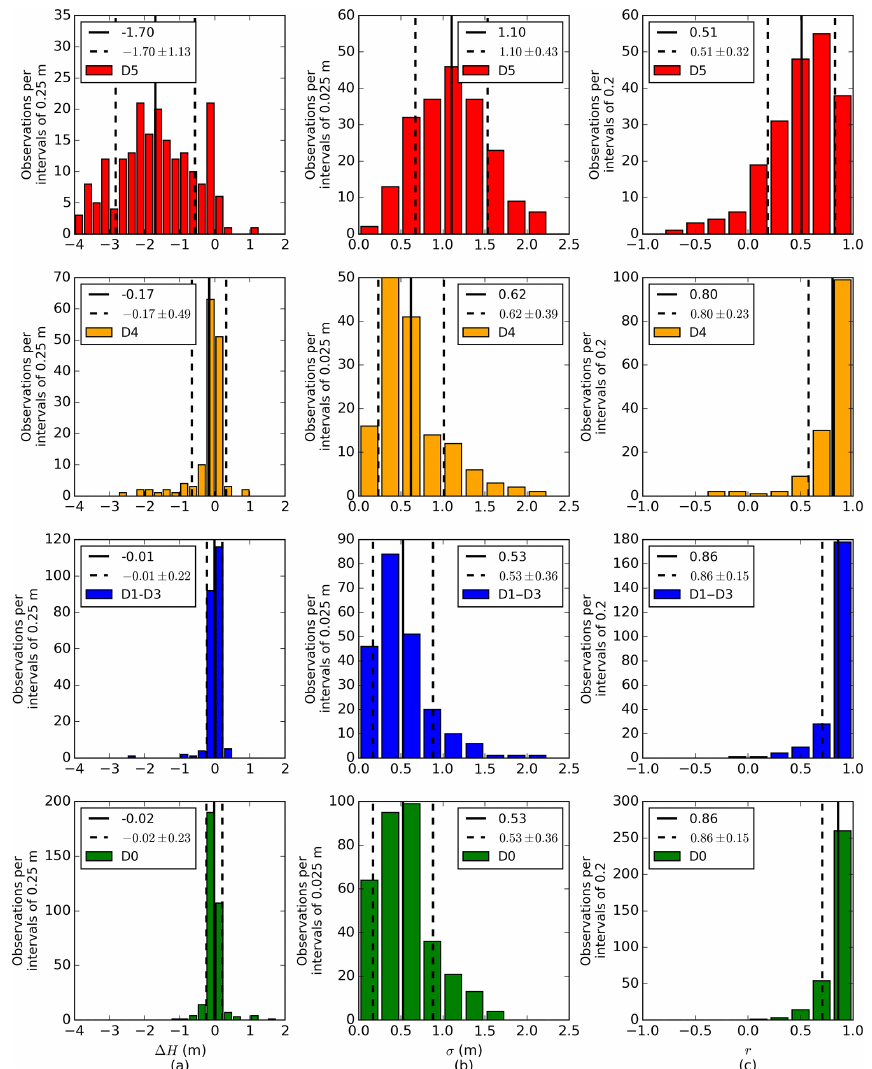
Figure 7. Histograms of the three parameters ( (cid:49)H , σ , r) calculated from the lidar DSMs for the buildings surveyed by Yamada et al. (2017), separated into four damage